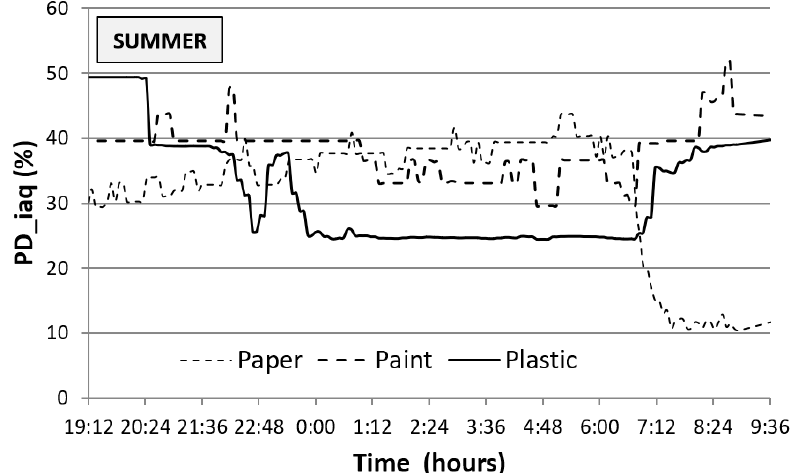
Figure 10. Indoor air acceptability (ACC IAQ ) predicted for each internal covering material during the summer season.